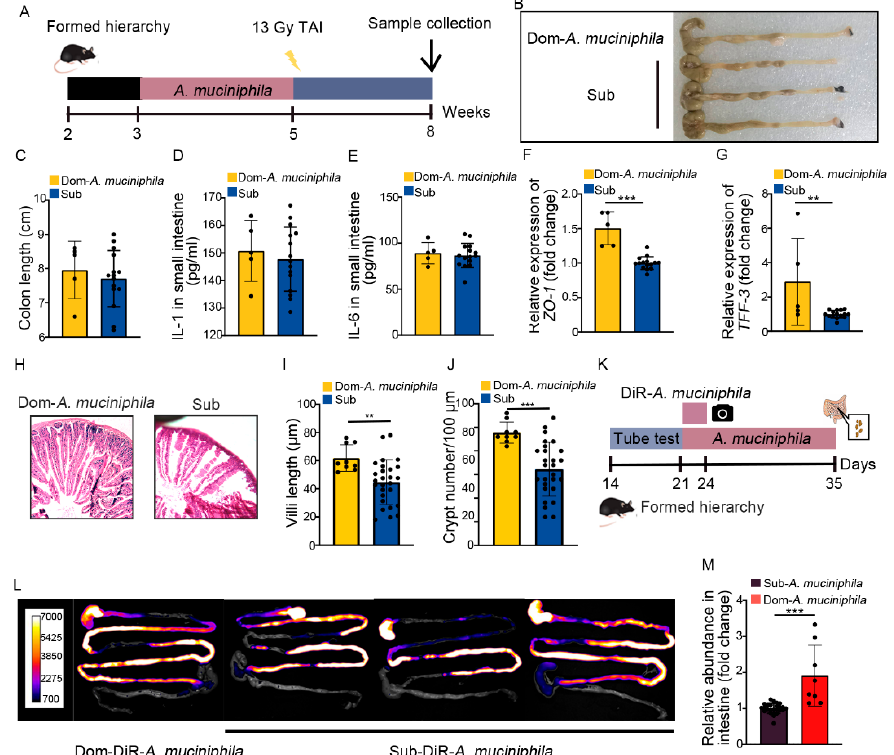
Figure 7. A. muciniphila stably colonizes in the GI tracts of Dom mice to mitigate intestinal radiation injury. ( A ) Experimental protocol. ( B ) Photographs of dissected colons. ( C ) Statistical comparison of colon lengths between the two groups. ( D , E ) The protein levels of IL − 1 and IL − 6 in the small intestine were measured by ELISA. ( F , G ) The mRNA expression levels of ZO − 1 and TFF − 3 in small intestinal tissues from Dom mice treated with A. muciniphila and Sub mice were examined by qRT − PCR. ( H ) The morphology of the small intestine was revealed by H&E staining. ( I ) Length of villi in small intestinal tissues. ( J ) Numbers of crypts in small intestinal tissues. ( K ) Experimental protocol. ( L ) In vivo fluorescence imaging performed on Dom and Sub mice given DIR − labeled A. muciniphila . ( M ) The relative abundance of A. muciniphila in small intestines of Dom and Sub mice was examined by q − PCR. Statistically significant differences are indicated: Student’s t test, n = 4 in Dom group, n = 12 in Sub group, ** p < 0.01 and *** p < 0.001.